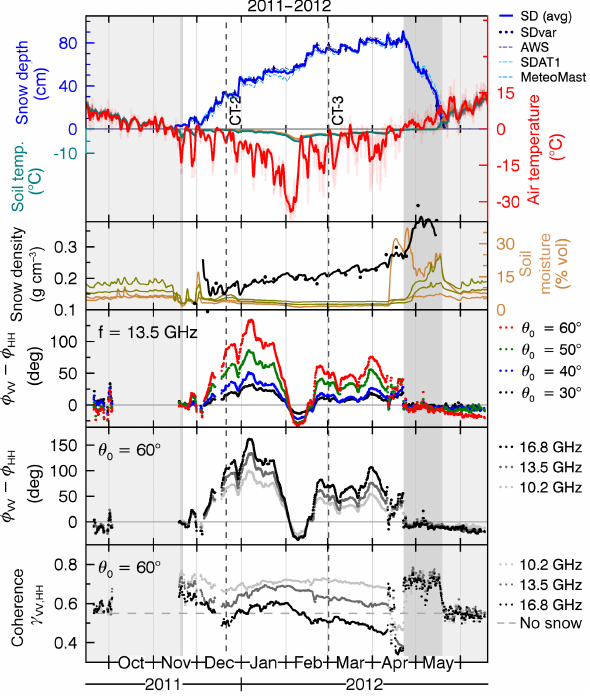
Figure 8. Winter season 2011–2012. Meteorological and radar data as shown in Fig. 6 and described in Sect. 4.6. Two vertical dashed lines shows the date when the profiles CT-2 and CT-3 were acquired.